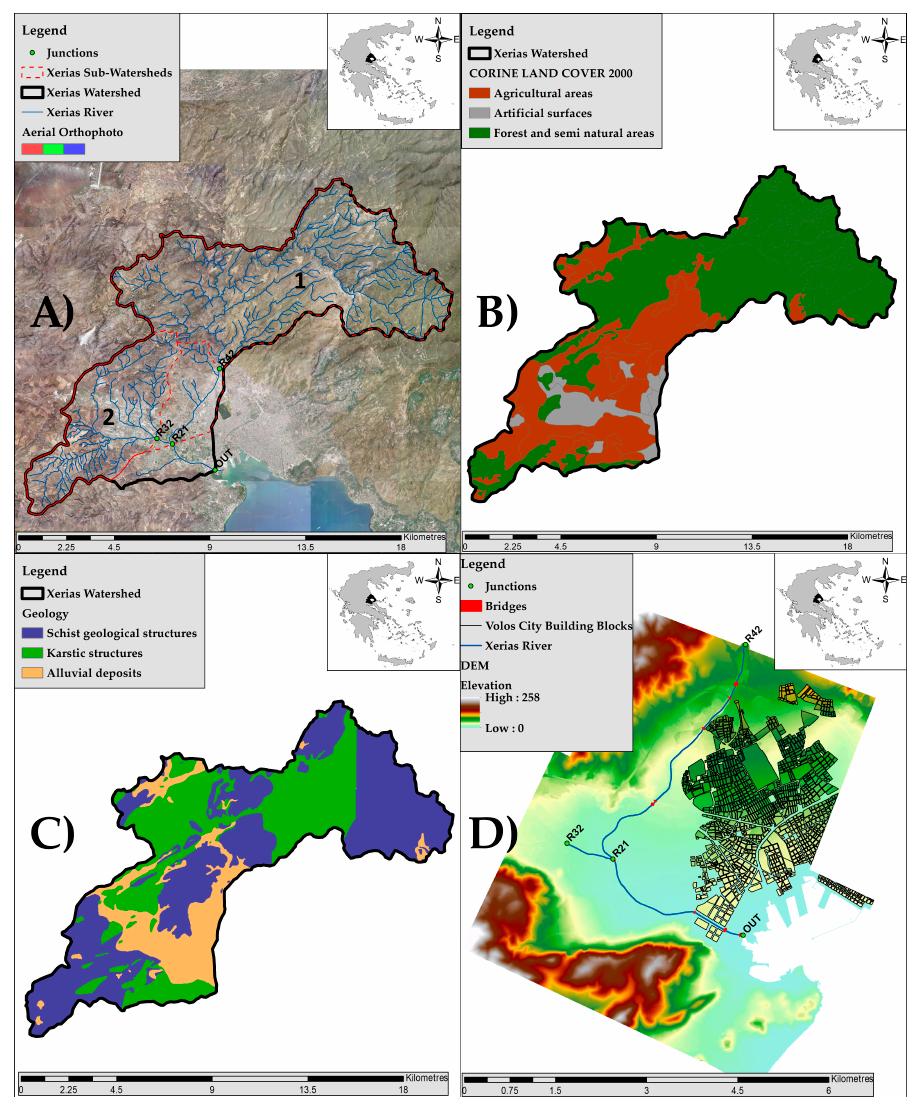
Figure 1. ( A ) Hydrologic analysis model of domain in Xerias watershed (black line) and sub-watersheds (dashed red line: (1) Upper Xerias sub-watershed (outlet R42), (2) Seskouliotis and Kakaviotis sub-watershed (outlet R32)) ( B ) Xerias watershed land cover, ( C ) Xerias watershed geology, ( D ) unified flood inundation model